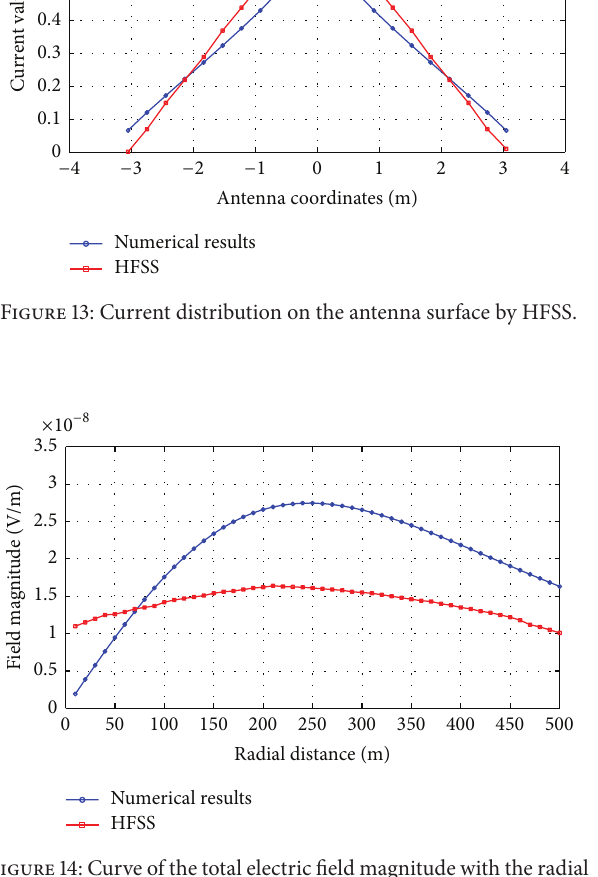
Figure 14: Curve of the total electric field magnitude with the radial distance by numerical results and